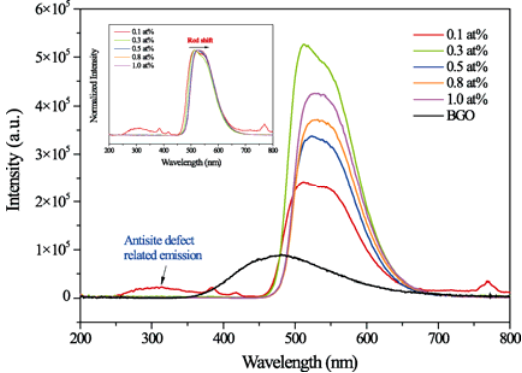
Fig. 6 XEL spectra of BGO single crystal and LuAG– Al 2 O 3 nanoceramics (72 mol% Al 2 O 3 ) doped with different Ce concentrations (1100 ℃ , 2 h). The inset is the normalized XEL spectra.